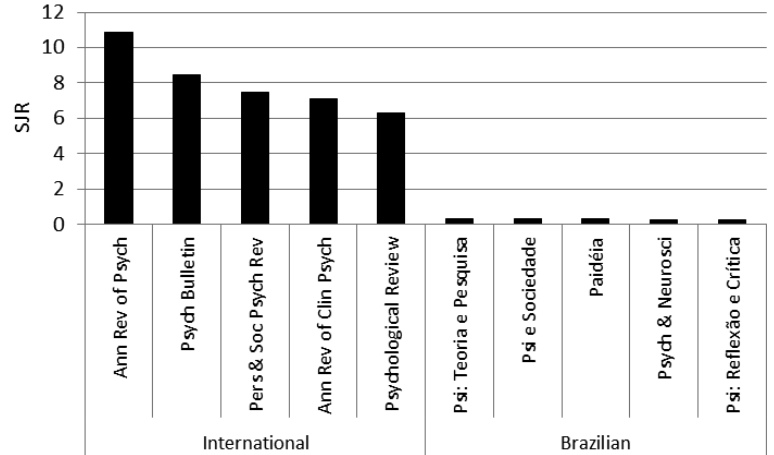
Figure 1 . SCImago Journal Ranking (SJR) of highest-ranking international (left) and Brazilian (right) psychology